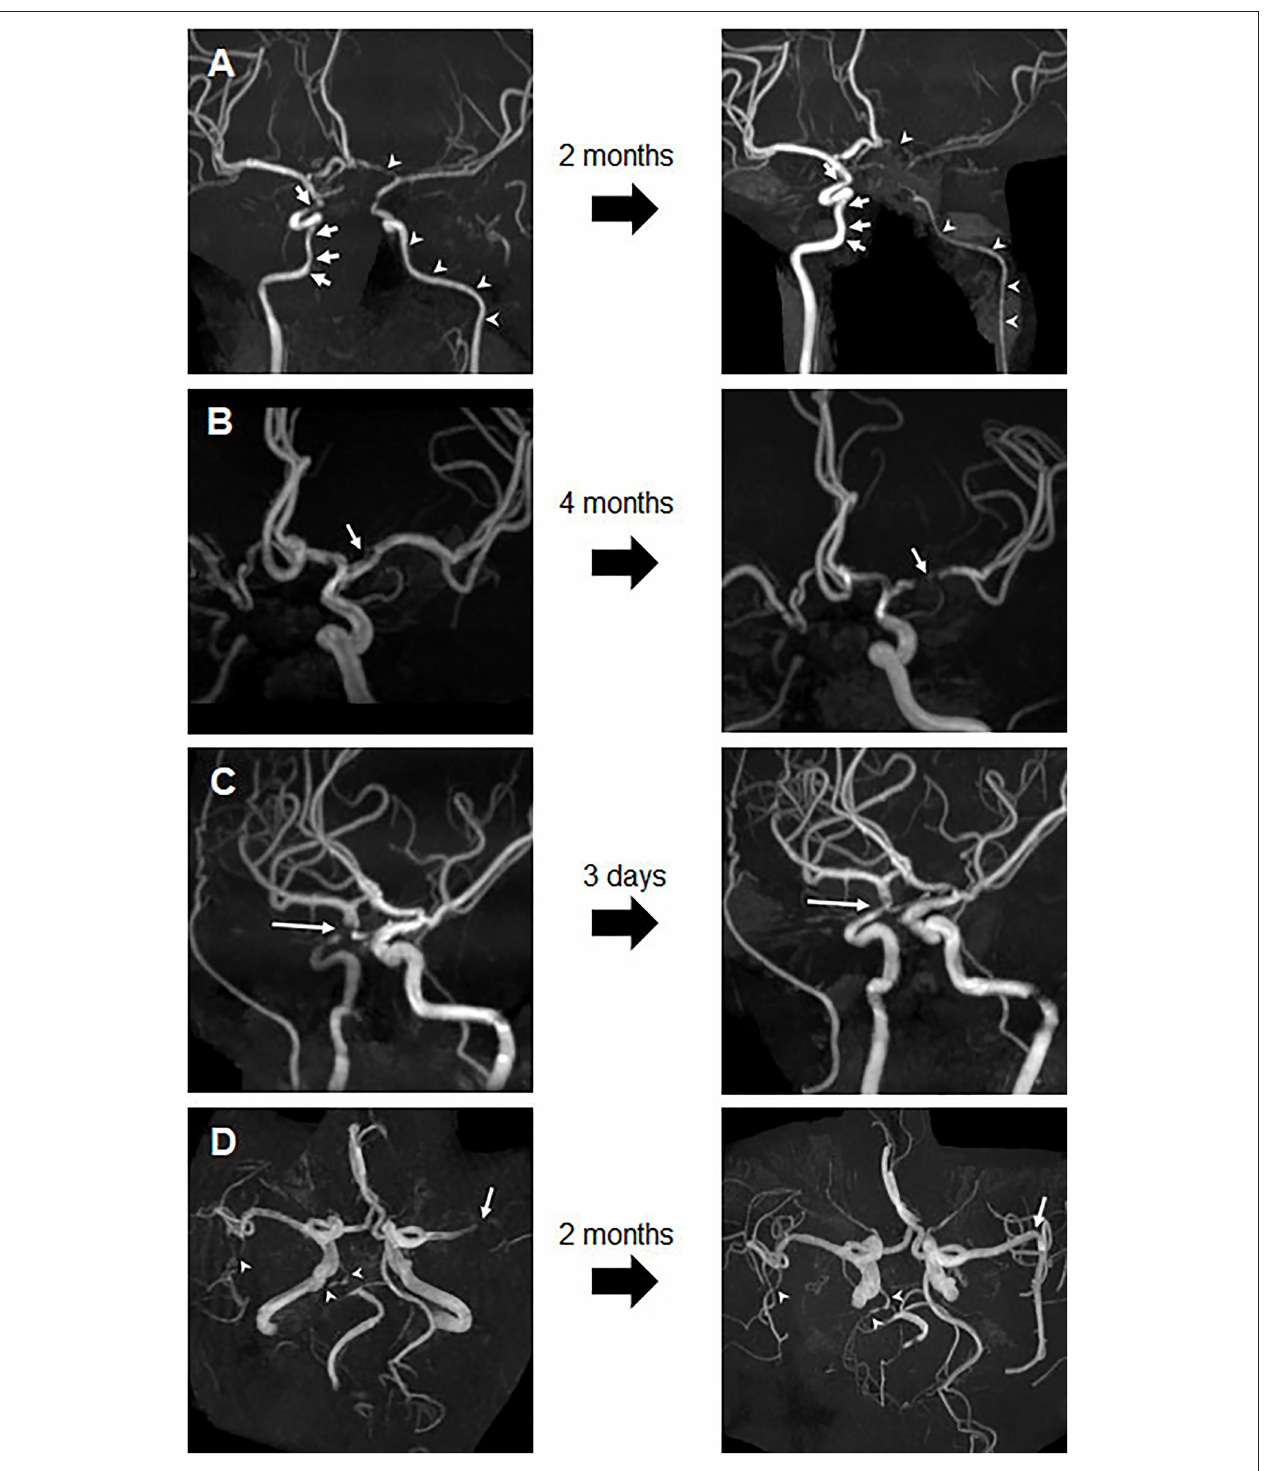
FIGURE 3 | Changes in stenosis on follow-up images. (A) Follow-up image of Patient 1 after 2 months, showing progression of the long-segmental diffuse stenosis in the left ICA and ACA (arrowhead) and improvement of focal stenosis in the right ICA (arrow). (B) Follow-up image of Patient 3 after 4 months, showing progression of the left MCA stenosis (arrow). (C) Follow-up image of Patient 5 after 3 days, showing significant improvement in the stenosis of the right distal ICA. (D) Follow-up brain MRA image of Patient 7 after 2 months, showing complete resolution of occlusion and M2 stenosis of the left MCA M1 (arrow), but no significant interval change in right MCA M2 and right PCA near total occlusion (arrowheads). ACA, anterior cerebral arteries; ICA, internal carotid artery; MCA, middle cerebral artery; MRA, magnetic resonance angiography; PCA, posterior cerebral artery.